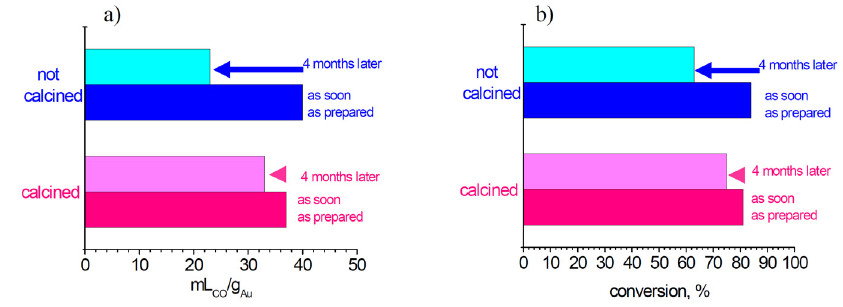
Figure 2. Trends of chemisorption ( a ) and conversion in LT-WGS reaction; ( b ) for 1AuSZ2 catalyst.